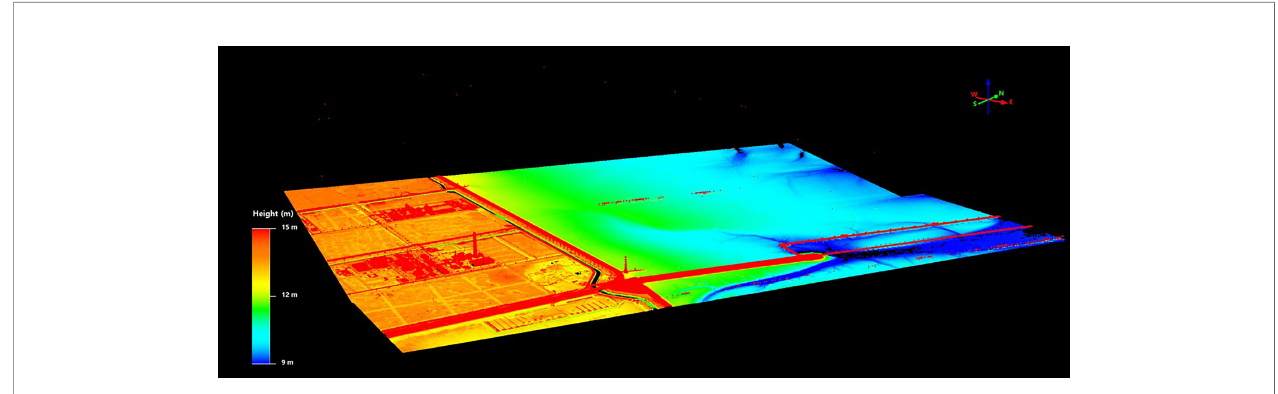
FIGURE 6 | The results of point cloud